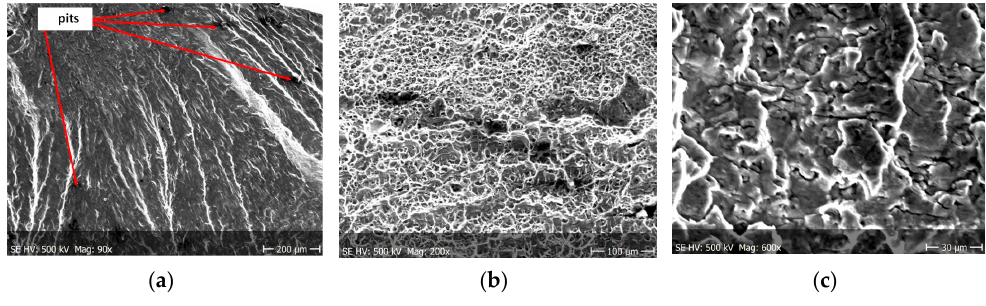
Figure 11. ( a – c ) . Fracture images within area A (Figure 10).